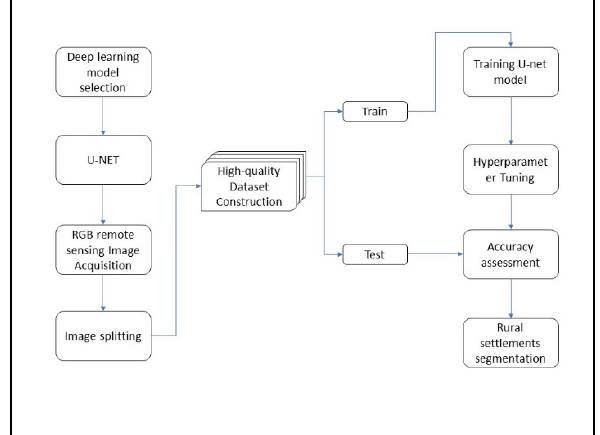
Figure 3 . The flowchart in this study